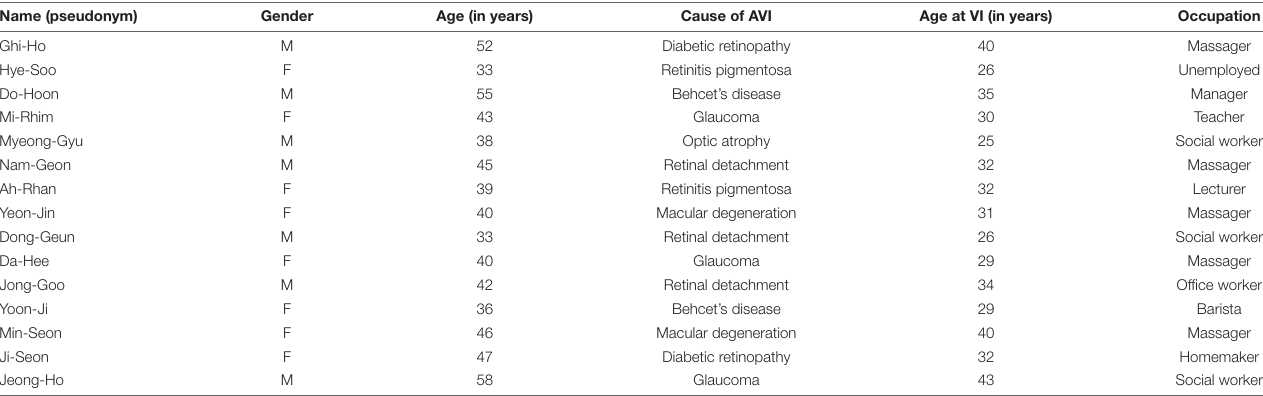
TABLE 1 | General characteristics of study participants ( N =15). Name